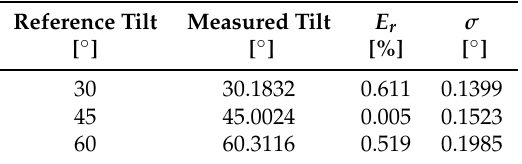
Table 1. Statistics obtained from measurements in different pseudo-static configurations: mean value, relative error and standard